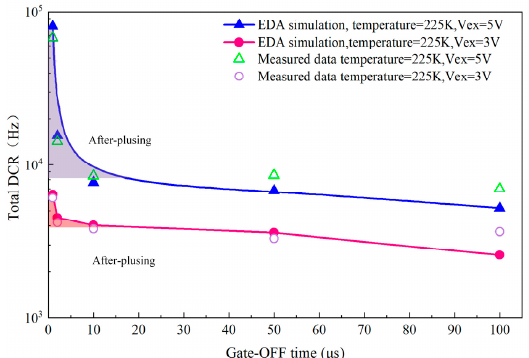
Figure 7. The variety of the total DCR with gate-OFF times.